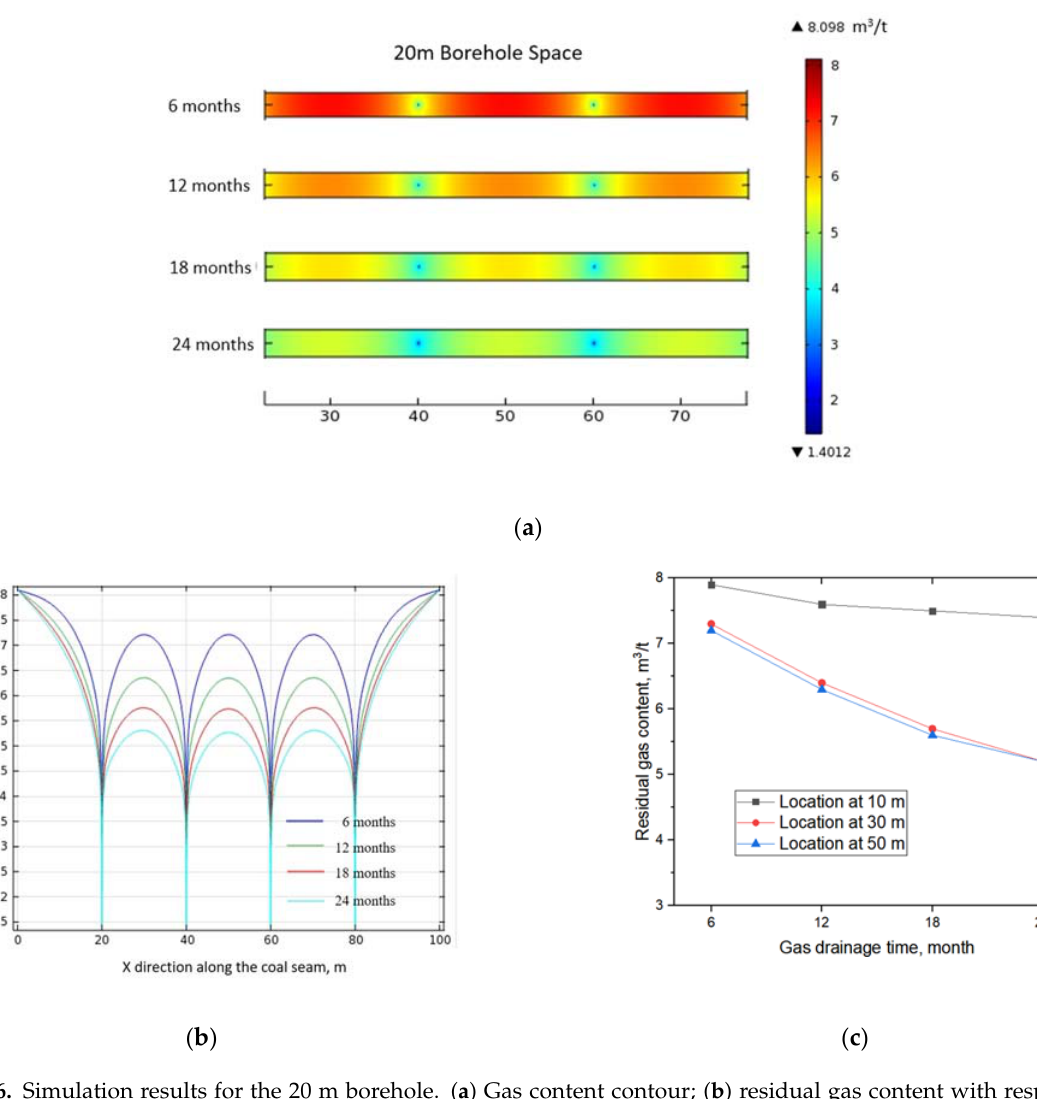
Figure 6. Simulation results for the 20 m borehole. ( a ) Gas content contour; ( b ) residual gas content with respect to X direction along the coal seam; ( c ) gas content at three points with respect to gas drainage time. Table 5. Gas drainage performance of different drainage conditions